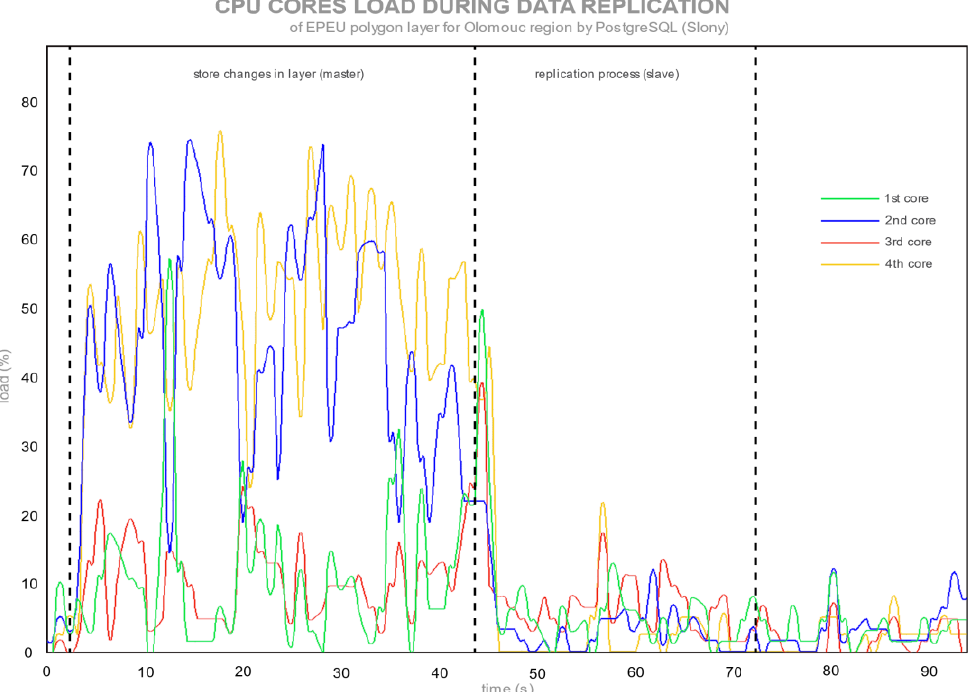
Figure 3. CPU core load during replication of EPEU layer by PostgreSQL (Slony).